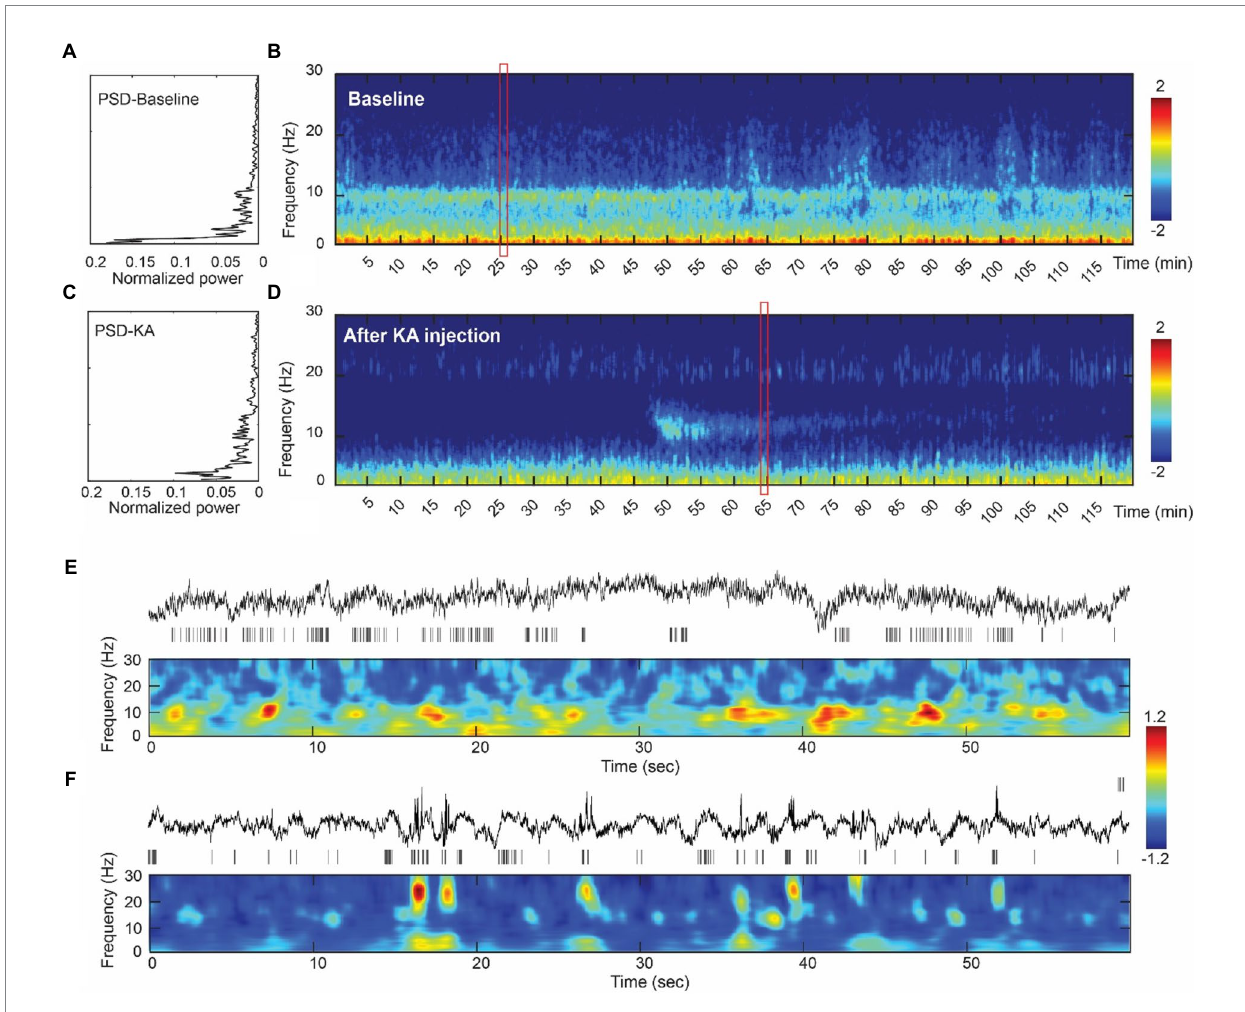
FIGURE 2 Assessment of the intracranial recordings before and after KA injection. (A) The analysis of power spectrum from the baseline recording. (B) An illustration of multi-tapper analysis from the 2-h epoch of baseline data. A clear eye-closed alpha band occurs in both PSD and multi-tapper plots. (C) Power spectrum plot from the animal after the KA-lesion (from week1). (D) The multi-tapper analysis from the 2-h epoch of the data after KA- lesion (from week1). (E) (Top-bottom) Demonstration of the 60 s local field potentials (LFPs) and the time-frequency decomposition (0–30 Hz). Data were obtained in the redbox shown in (B) . (F) Similar plots as Figure E, but obtained from the data after KA injection (redbox in D). Compared to the baseline, data from the post-KA period showed a suppression of the lower frequency band (delta wave, 0–3 Hz) and a decrease of the alpha band (10 Hz), but an increase of the spindle-like activity (see the bursts > 20